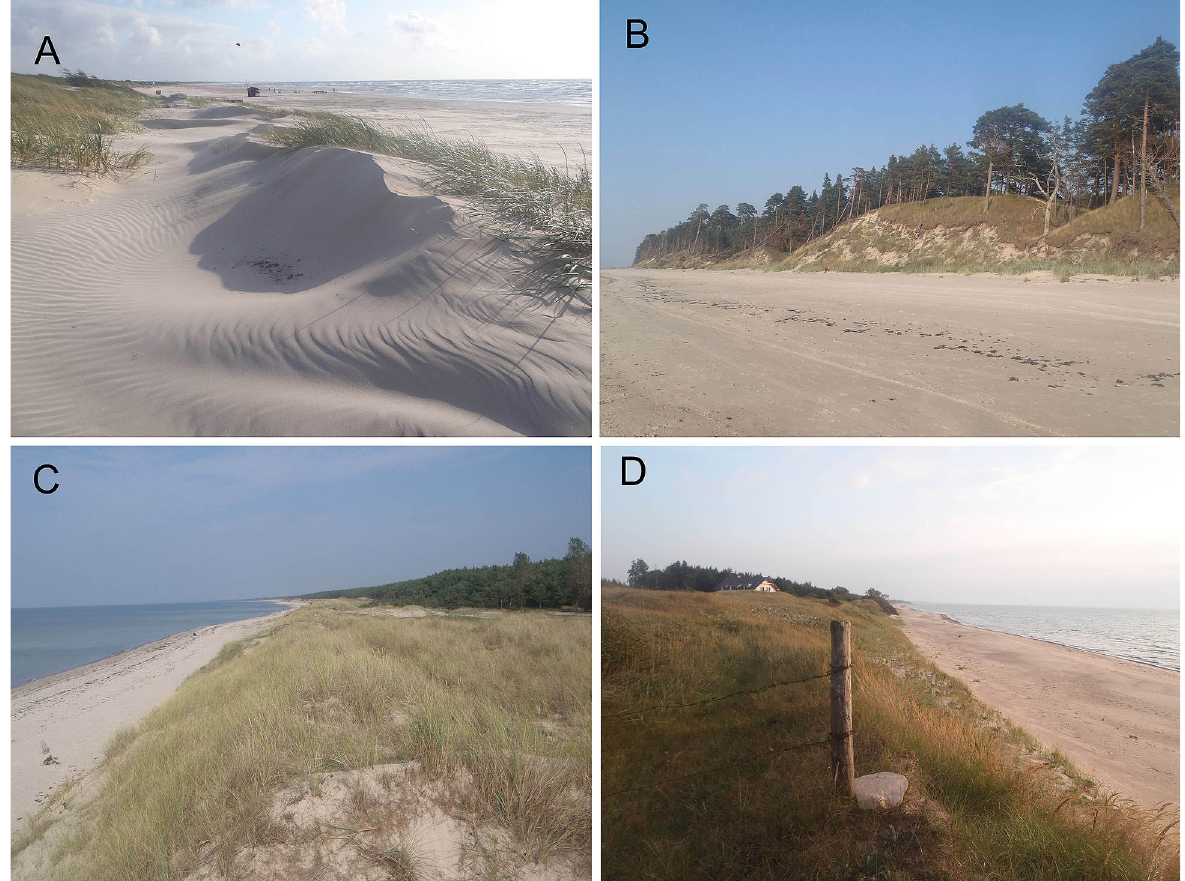
Fig. 8. Dunes of East Baltic coast (Photo T. Łabuz